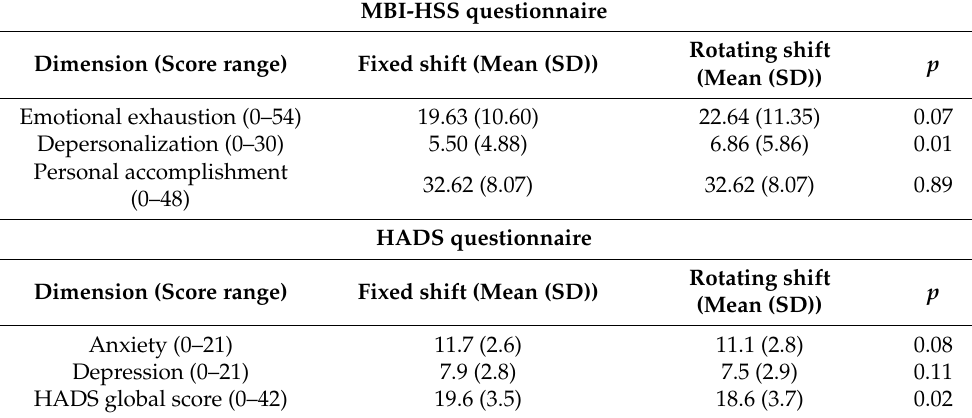
Table 6. MBI-HSS and HADS